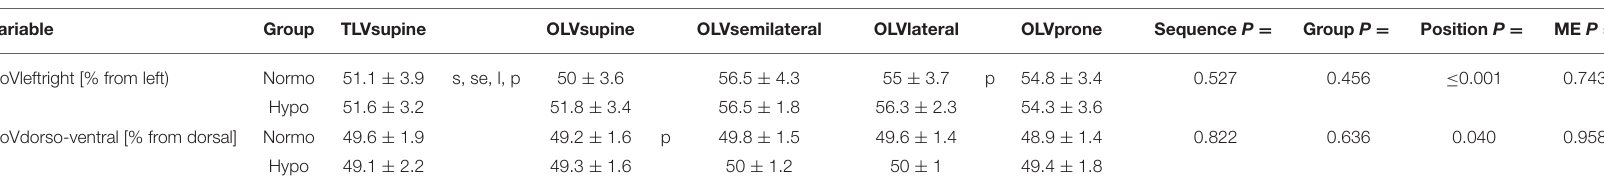
TABLE 3 | Electrical impedance tomography of the left lung. Variable Sequence P = Group P = Position P = ME P = CoVleftright [% from left) CoVdorso-ventral [% from